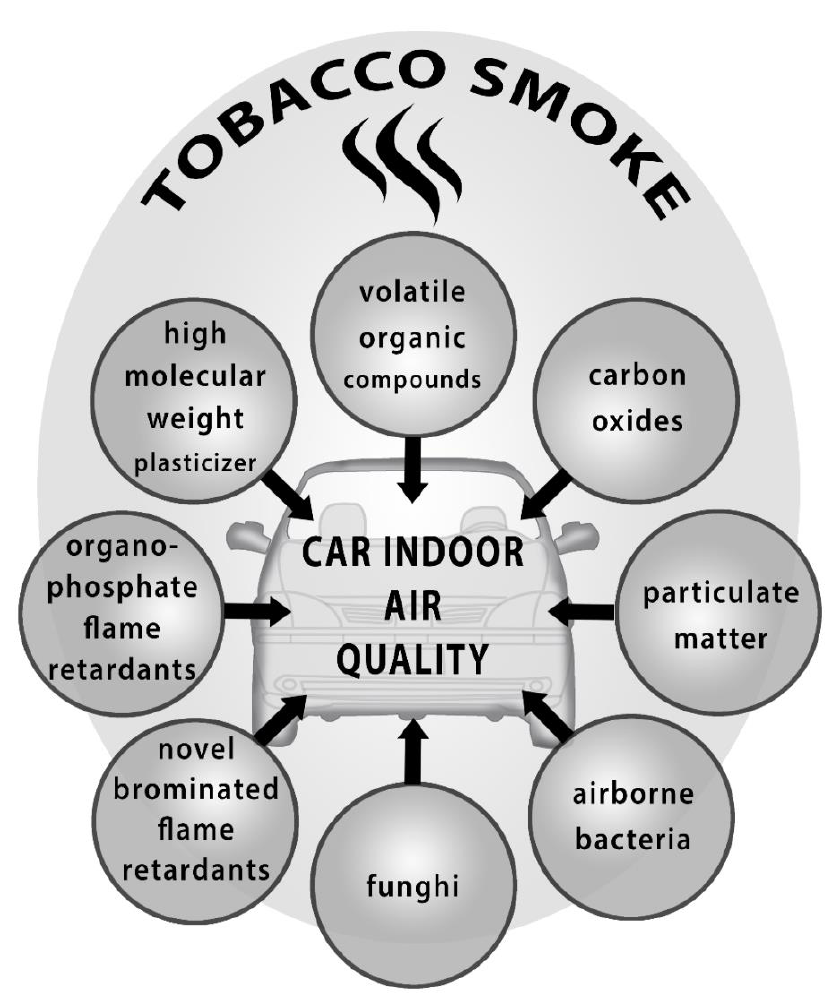
Figure 1. Summarized negative factors influencing a car’s indoor air quality.